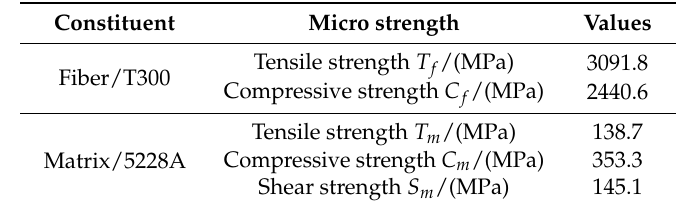
Table 2. Micro strength of